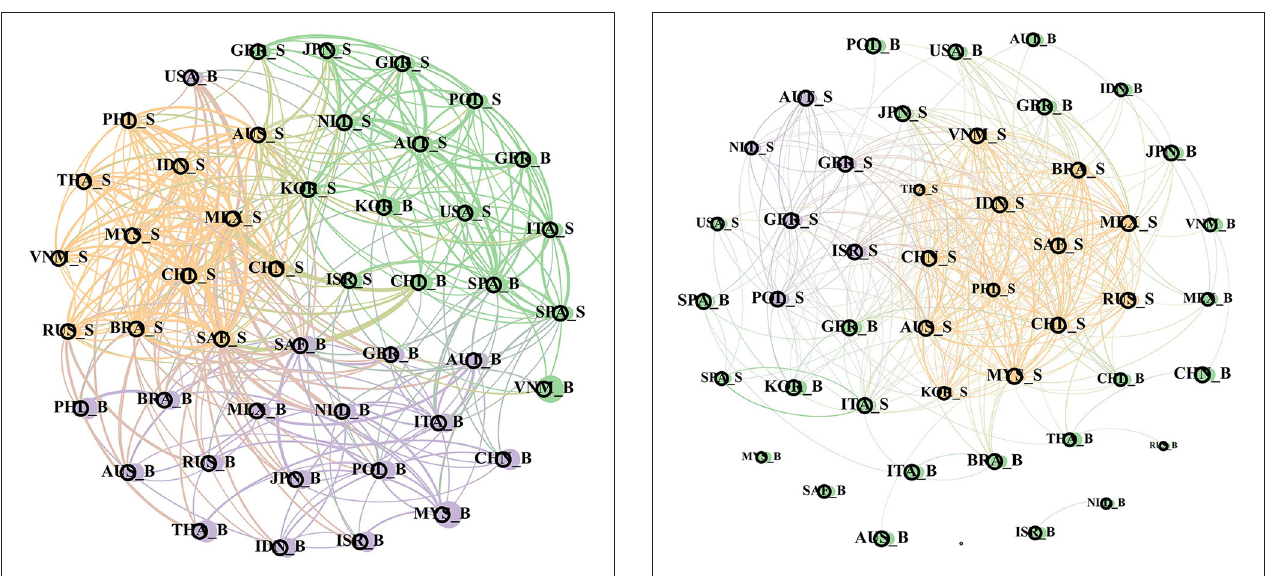
FIGURE 2 | Bank-sovereign risk network in time domain.